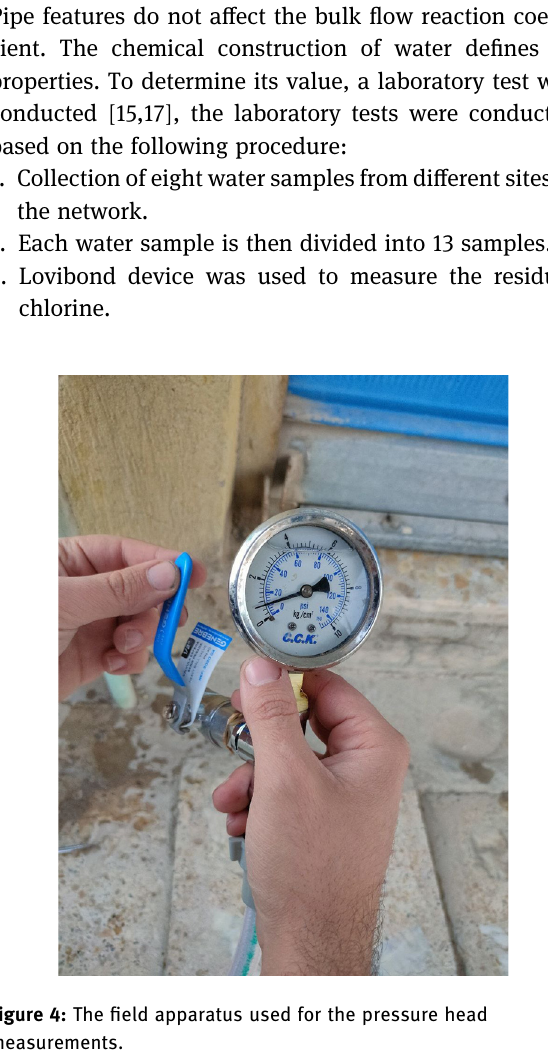
Figure 2: WDS of Al - Nidaa and Al - Milad districts.